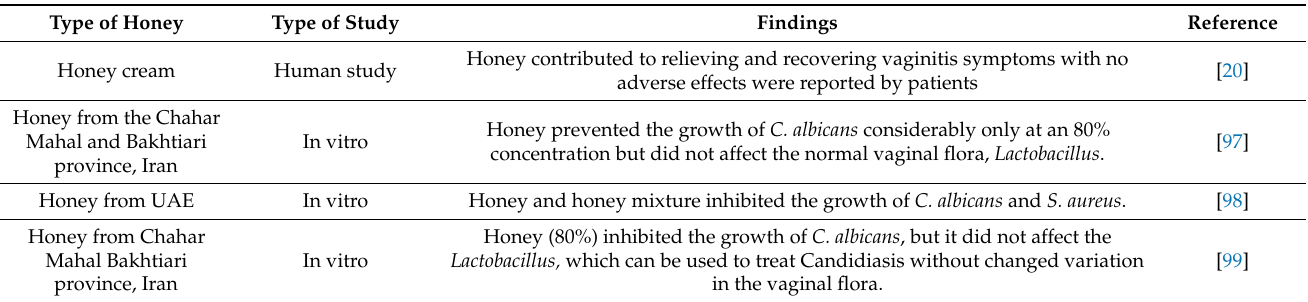
Table 4. Summary of the roles of honey as a vulvovaginal candidiasis